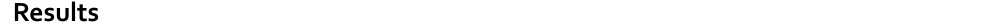
Table 1. We probed COVAM with CCP collected from 99 US PCR confirmed COVID-19 plasma donors who recovered from the infection 1–2 months prior to CCP collection. The multiplex COVAM results were analyzed using two computational approaches, either a generalized linear model (glm) or random forest (RF) to classify individual specimens as either reactive or non-reactive against the SARS-CoV-2 antigens. The binary predic- tion results were compared with the FDA EUA VITROS CoV2T chemiluminescence immunoassay from Ortho (reactive: S/C ≥ 1.0) and with an RVPNT assay (reactive: neutralization titer with > 5) inhibition of infection [NT50] > 40) developed at Vitalant and tabulated in Table 1. Compared to the VITROS CoV2T assay, there is 93%, and 91% concordance with the RVPNT, and COVAM predictions, respectively. Three specimens that were negative by the VITROS CoV2T assay were also negative by RVPNT and two of these for COVAM assays. Ninety percent of the specimens are completely concordant among all comparisons, including 88 seropositive by all tests and two seronegative by all tests. All of the discordances are found in ten samples that showed low positive titer on the VITROS CoV2T immunoassay. Among these, eight were considered non-reactive on the RVPNT test and three considered non-reactive on the COVAM prediction (using a 60% RF probability cutoff). The COVAM data are summarized in the heatmap in Fig. 1. There are 99 specimen IDs along the x-axis and 65 antigens along the y-axis (Supplementary Table 1). The antigens are grouped according to the virus from which they are expressed. The top 11 antigens are from SARS-CoV-2 and the quantitative COVAM IgG Ab results from these antigens were used to cluster the specimens into 3 groups as shown in the dendrogram on top of the heatmap (Fig. 1). The normalized signal intensity on the COVAM for each antigen was compared with either the VITROS CoV2T S/C levels or the RVPNT NT50 titers. The antibody reactivity to SARS-CoV-2 S1 and RBD containing antigens present on the COVAM correlates with the VITROS CoV2T or the RVPNT titers. Most notably,